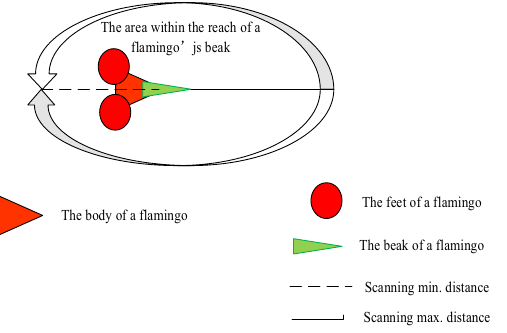
Figure 3. Beak scanning